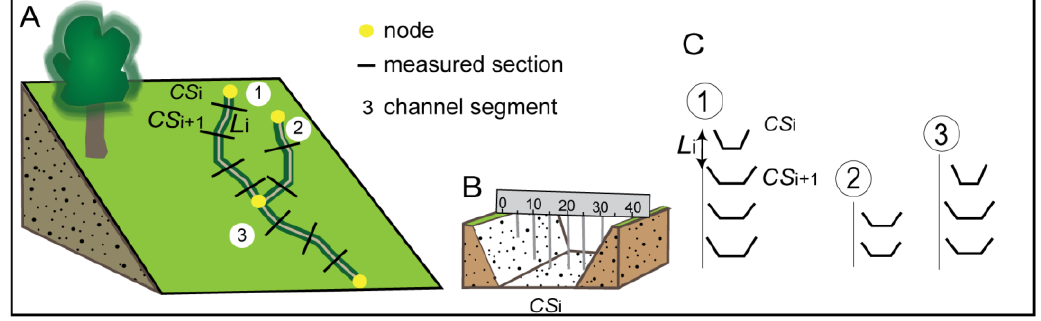
Figure 6. Sketch of the field mapping procedure. ( A ) Measurement points in the field. ( B ) Cross section measurements. ( C ) Measurements of the channel